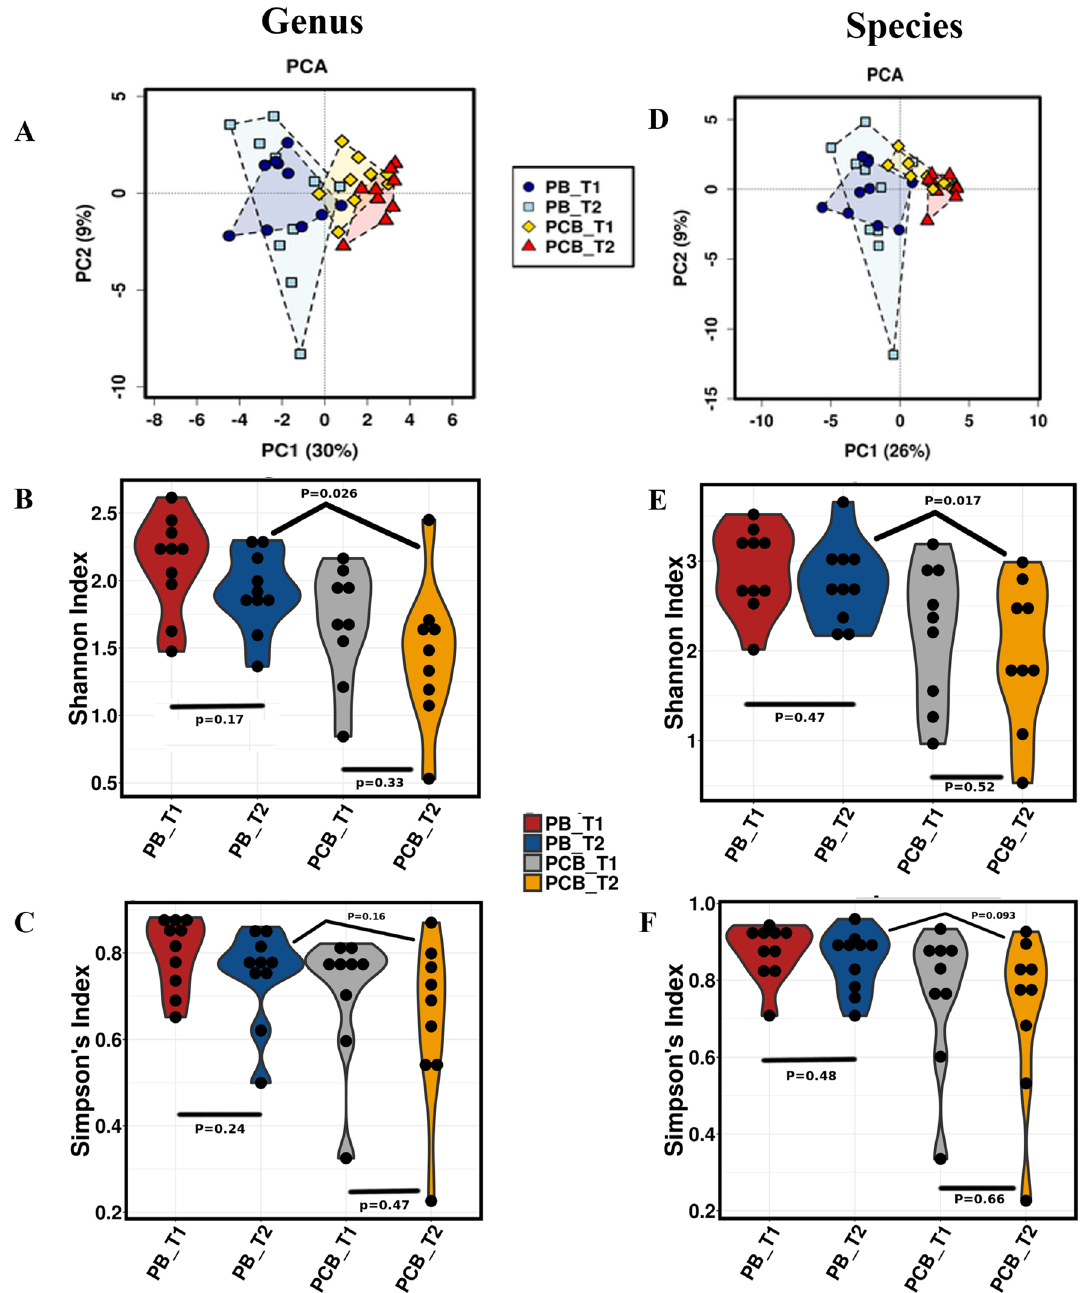
Figure 1. The impacts of a stressful ship voyage on the gut microbiota of expedition members. A , D - PCA of the gut microbiome in the PCB and PB group between baseline (day 0) and after the completion of ship voyage (day 24) at genus and species level. B , E - Shannon index represented microbial alpha diversity of gut microbiome, within the groups and between the groups after the completion of ship voyage. Significant p -value ( p < 0.05) was observed between PCB_T2 and PB_T2 at both genus and species level. C , F - Simpson’s index represented microbial alpha diversity of gut microbiome, within the groups and between the groups after the completion of ship voyage. p -value < 0.05 was considered statistically